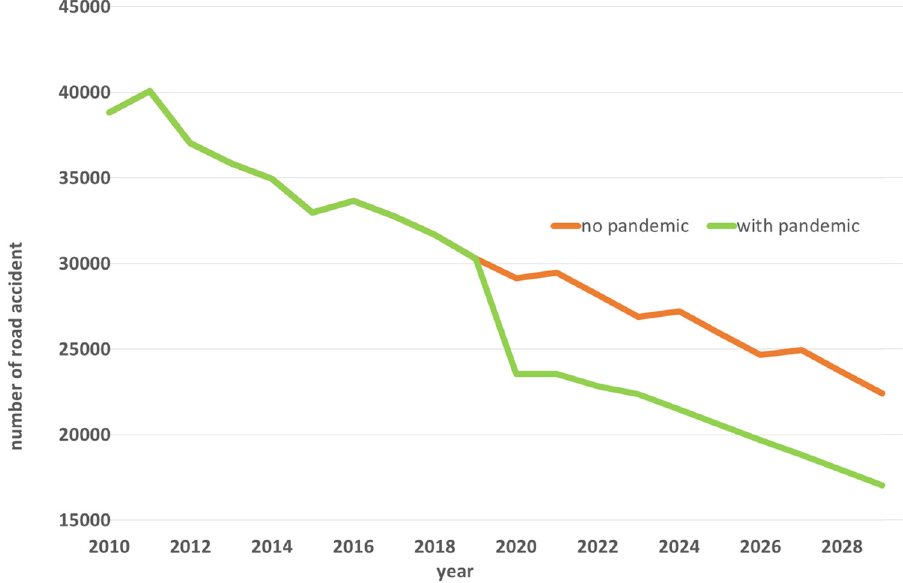
Figure 8: Comparison of the number of road accidents in Poland with and without the